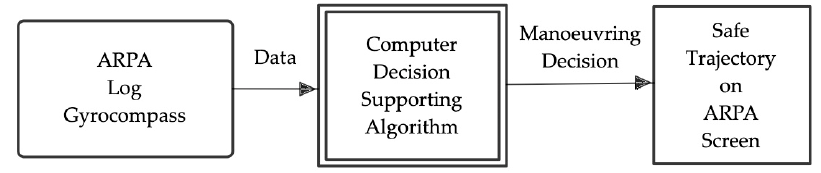
Figure 2. Structure of the decision support system.